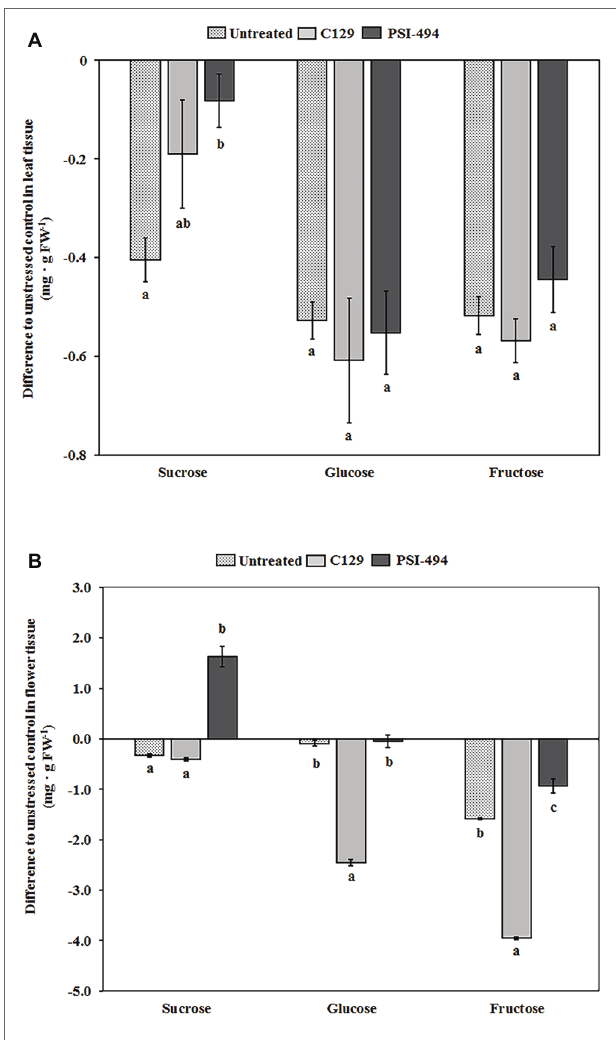
FIGURE 5 | Effect of heat stress and ANEs on endogenous soluble sugars of tomato plants. The levels of glucose, fructose, and sucrose were determined by HPAEC-PAD in (A) leaf tissue and (B) flower tissue of 122-day-old plants. Measured results were expressed as difference of the three heat stressed group samples (Untreated, C129, PSI-494) with respect to the unstressed control. The straight line at the “0” level represents the unstressed control and histograms represent the absolute variations of heat stressed plants. Different letters within the same soluble sugar indicate statistically significant differences between the treatments based on one- way ANOVA Tukey’s HSD test at p ≤ 0.05. Number of biological replicates = 4.